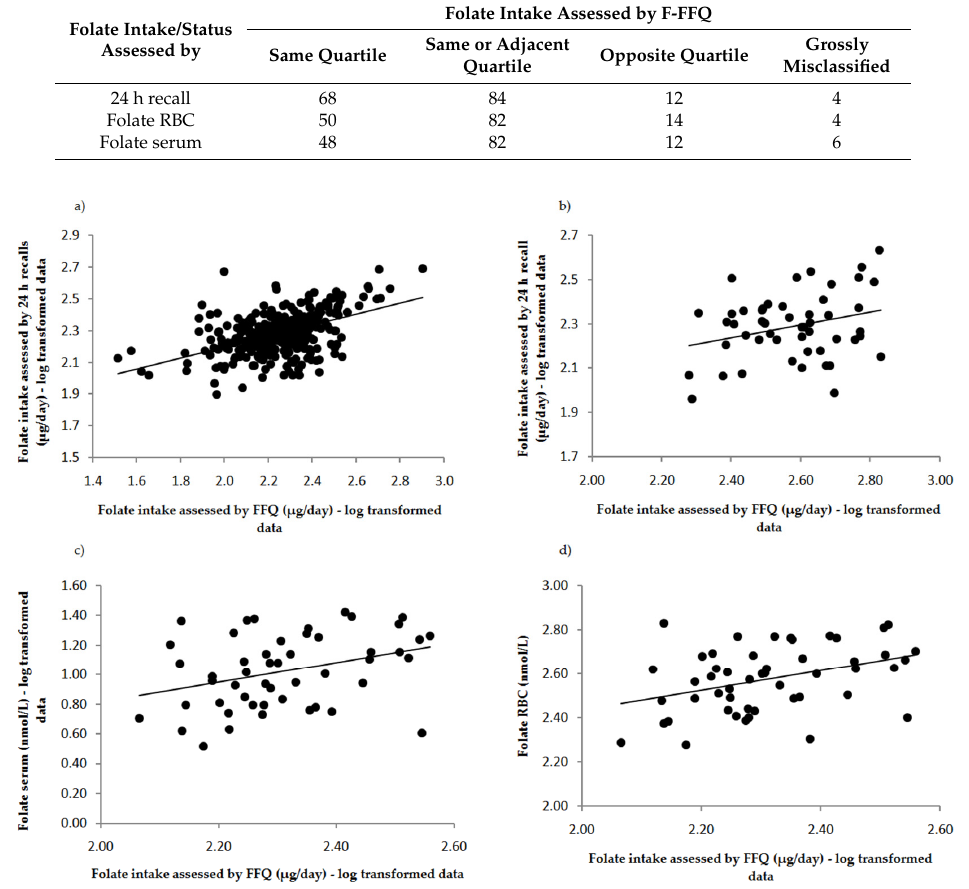
Figure 2. Correlations between folate intake assessed by the F-FFQ and the average of 24 h recalls in: ( a ) total sample ( n = 503); and ( b ) validation subsample ( n = 50); and folate intake assessed by the FFQ and: ( c ) folate serum concentration; and ( d ) red blood cells (RBC) folate concentration among Serbian women of reproductive age. All correlations were significant: ( a ) r = 0.56, p < 0.001; ( b ) r = 0.57, p < 0.001; ( c ) r ser = 0.28, p < 0.01; and ( d ) r rbc = 0.37, p < 0.01.